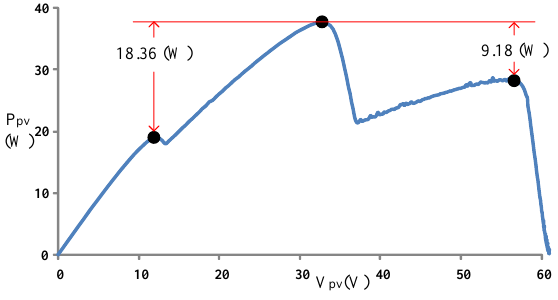
Figure 21. Analysis on the P–V characteristic curve of Case 2.